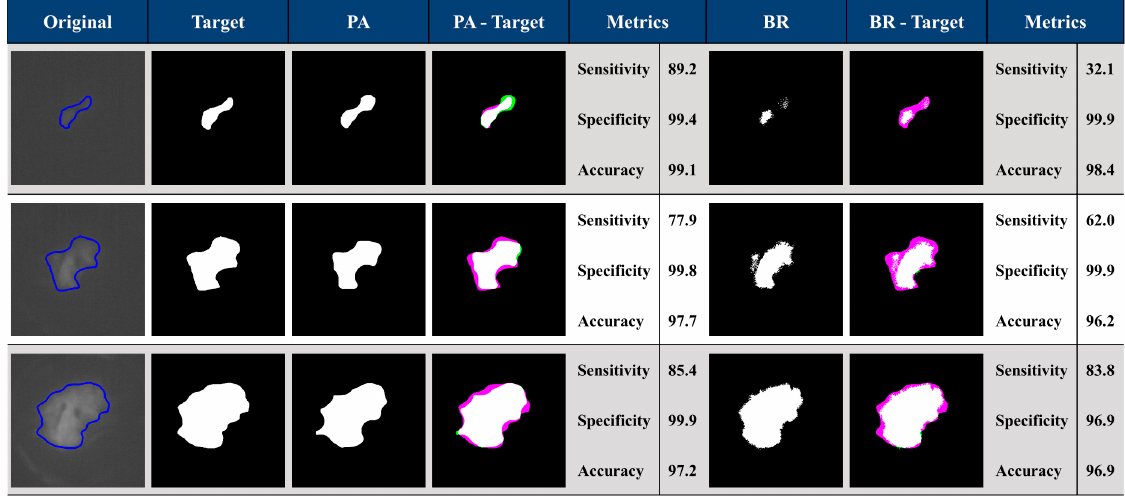
Figure 14. Evaluation of the metric at λ = 1.4 BDI.